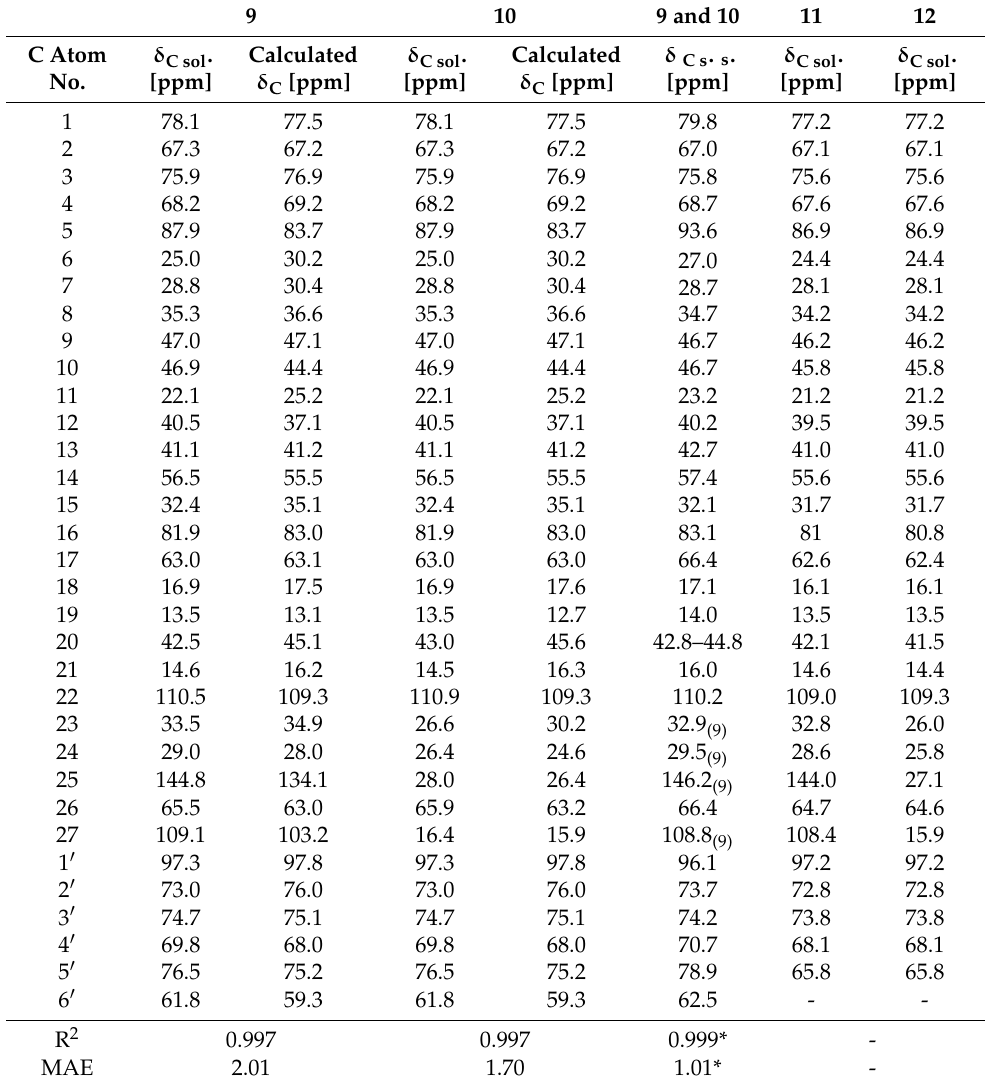
Table 5. 13 C NMR chemical shifts ( δ in ppm) for compounds 9 , 10 pentahydroxy galactosides (sol: pyridine-d5; s.s.: solid state) with the calculated with the calculated chemical shifts ( δ in ppm) and 11 , 12 (sol: pyridine-d5). Verification parameters at the bottom of the table: correlation coefficients R 2 and mean absolute errors